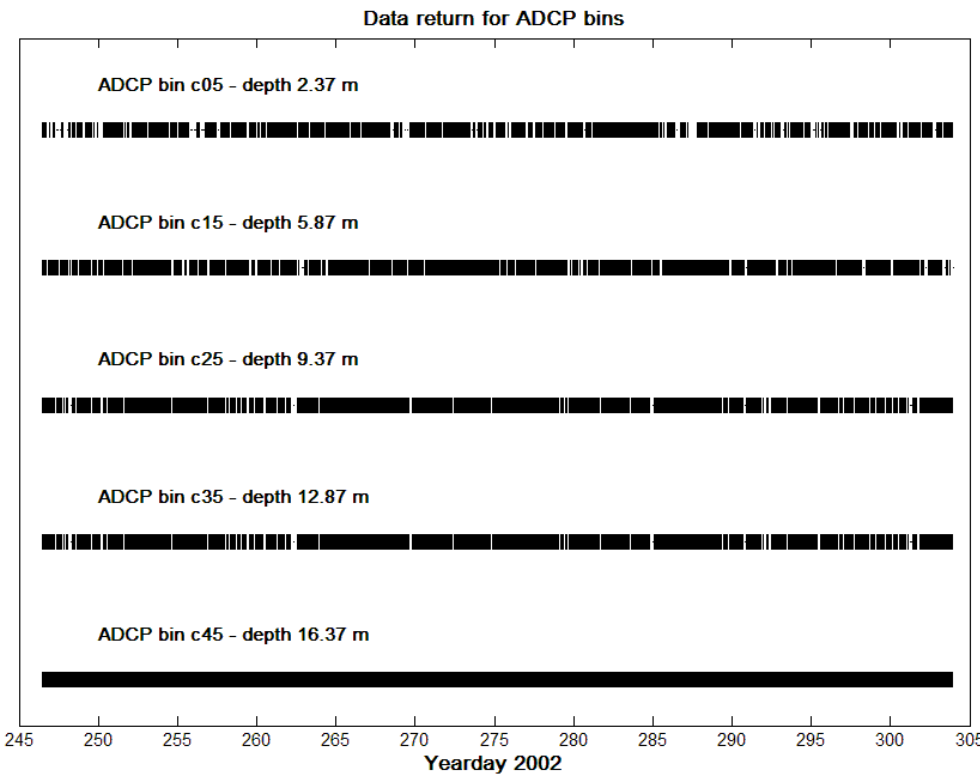
Fig. 2. Data availability for the period September–October 2002, for five ADCP bins named C05, C15, C25, C35, C45, located, respectively, at the nominal depth of 2.37m, 5.87m, 9.37m, 12.87m,